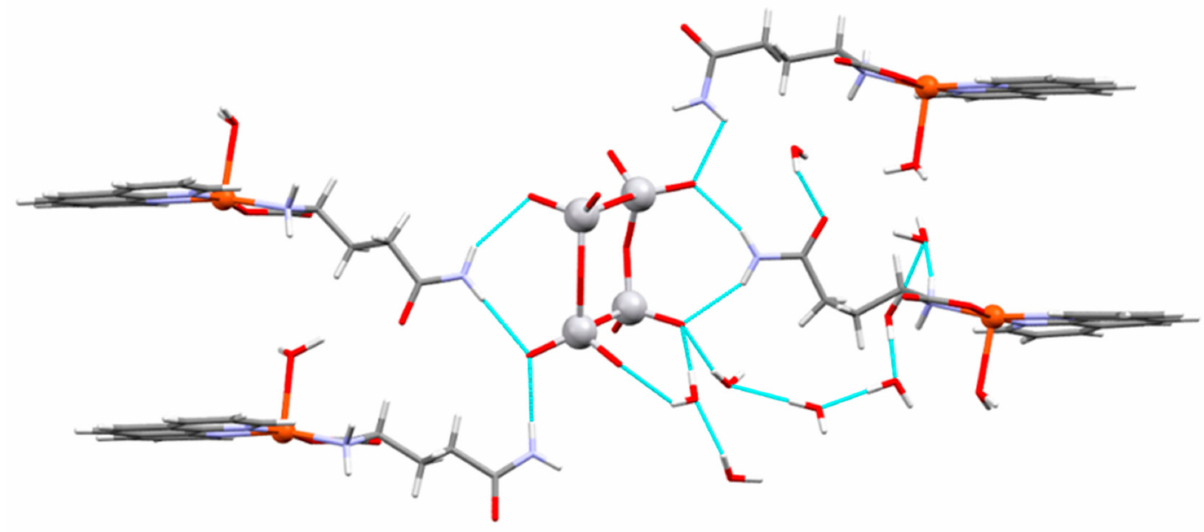
Figure 2. Representation of Compound 1 , where anti-conformers are on the right and syn-conformers are on the left. Blue lines indicate hydrogen bonds.